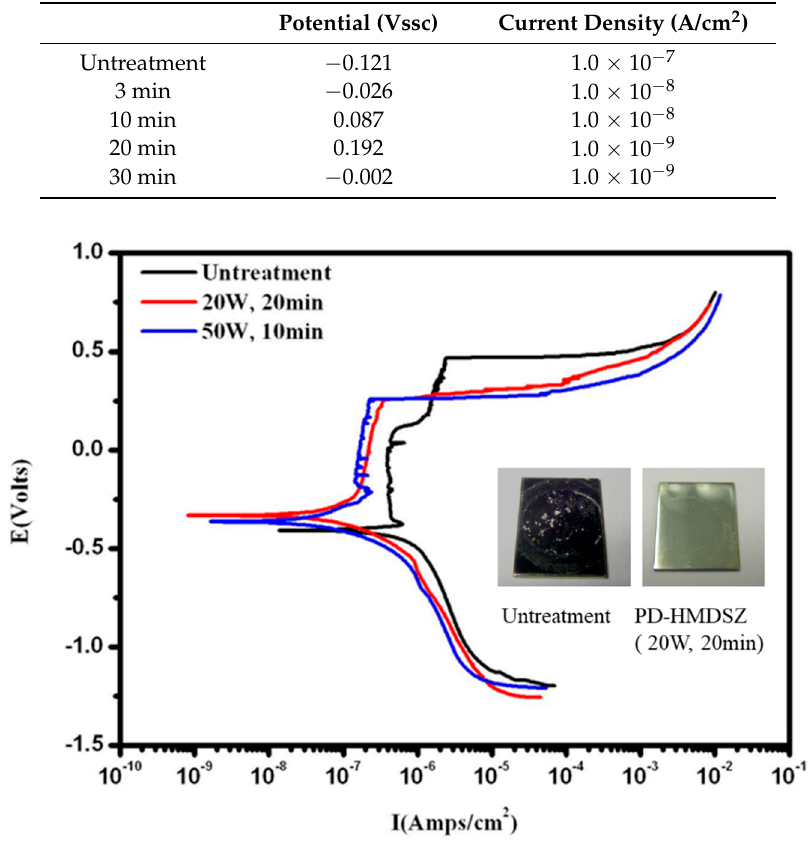
Table 4. Corrosion potential (Vssc) and current density (A/cm 2 ) of PD-HMDSZ (50 W, 60 mtorr) onto a stainless steel surface with different treatment times.